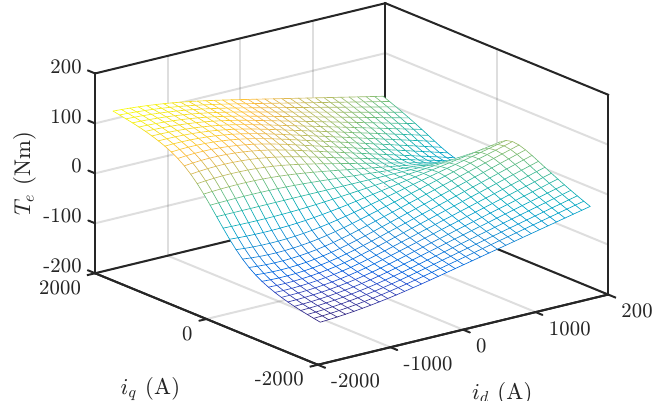
Figure 4. Original torque map for electromagnetic